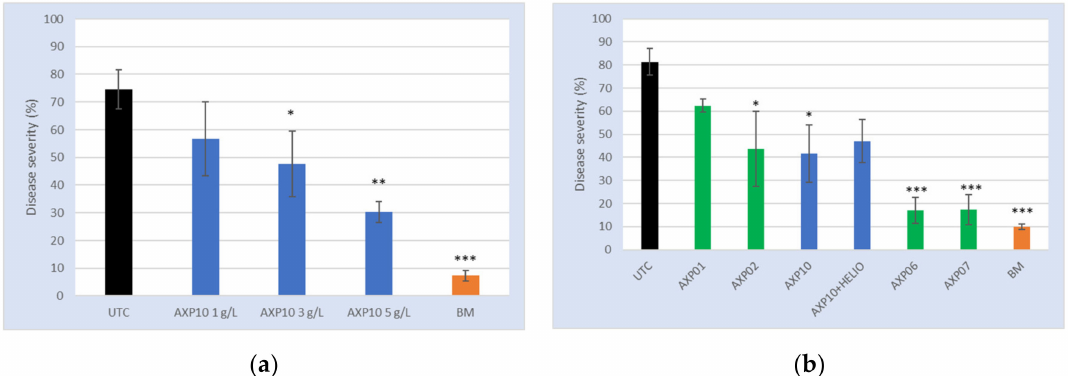
Figure 3. Greenhouse tests: ( a ) Disease severity evaluated on leaves L4 to L2 treated with AXP10 at 1, 3, and 5 g / L, and the Bordeaux mixture (BM) as the reference product. Leaves are numbered from the top of the plant (L1 being the youngest at the top). The untreated control (UTC) was spread with demineralized water. ( b ) Comparison of the formulated products AXP01, AXP02, AXP06, AXP07, AXP10 + HELIOSOL ® , and pure active substance (AS) AXP10 at a rate of 3 g / L of AS. AXP01 and AXP02 contained 50% AS and were prepared at 6 g / L, while AXP06 et AX07 contained 62.5% AS and were prepared at 4.8 g / L. HELIOSOL ® was used at a rate of 1.25 mL / L, while BM was used at 6.25 g / L. *: p < 0.05; **: p < 0.01; ***: p <